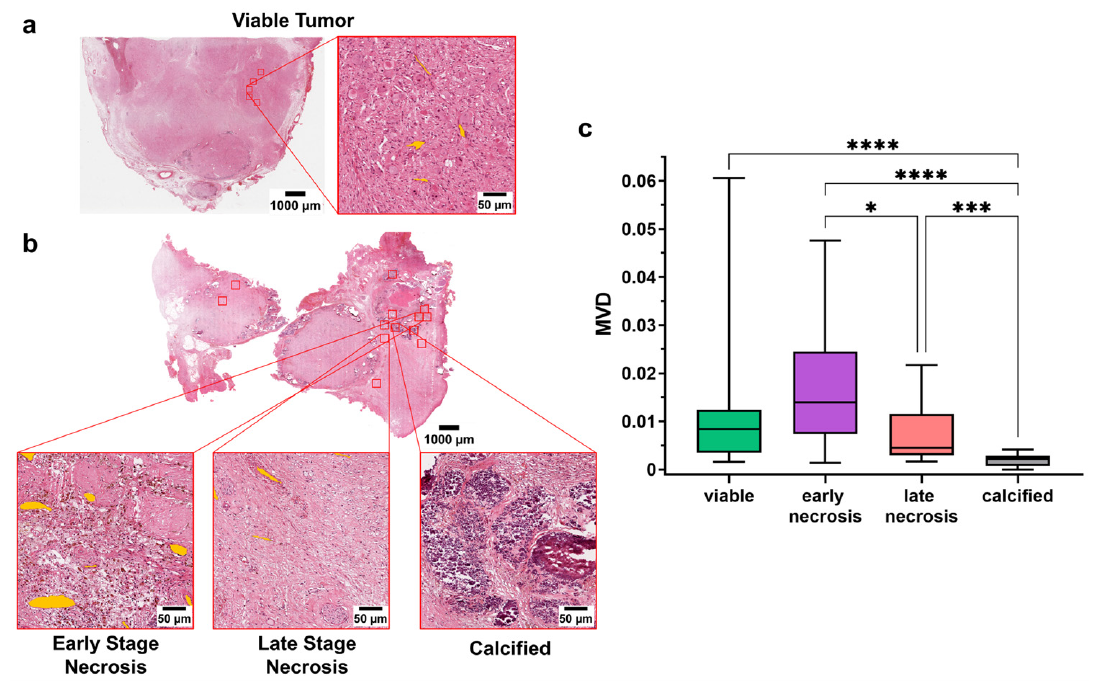
Figure 3. ( a ) Whole slide image and magnification of one of the ROI from a representative patient after induction chemotherapy (udNB). Annotated vessels are shown in orange; ( b ) Whole slide image and magnification of one of the ROI from a representative patient after induction chemotherapy (udNB). Magnified regions show the different histological components of the non-viable components after induction chemotherapy. Annotated vessels are shown in orange; ( c ) Boxplot showing the distribution of patients’ MVD in viable and non-viable regions after induction chemotherapy (viable = 26 patients; early necrosis = 18 patients; late necrosis = 24 patients; calcified = 23 patients). Box represents the interquartile range. Bars represent the 5–95% range. * p < 0.05; *** p < 0.001; **** p < 0.0001.